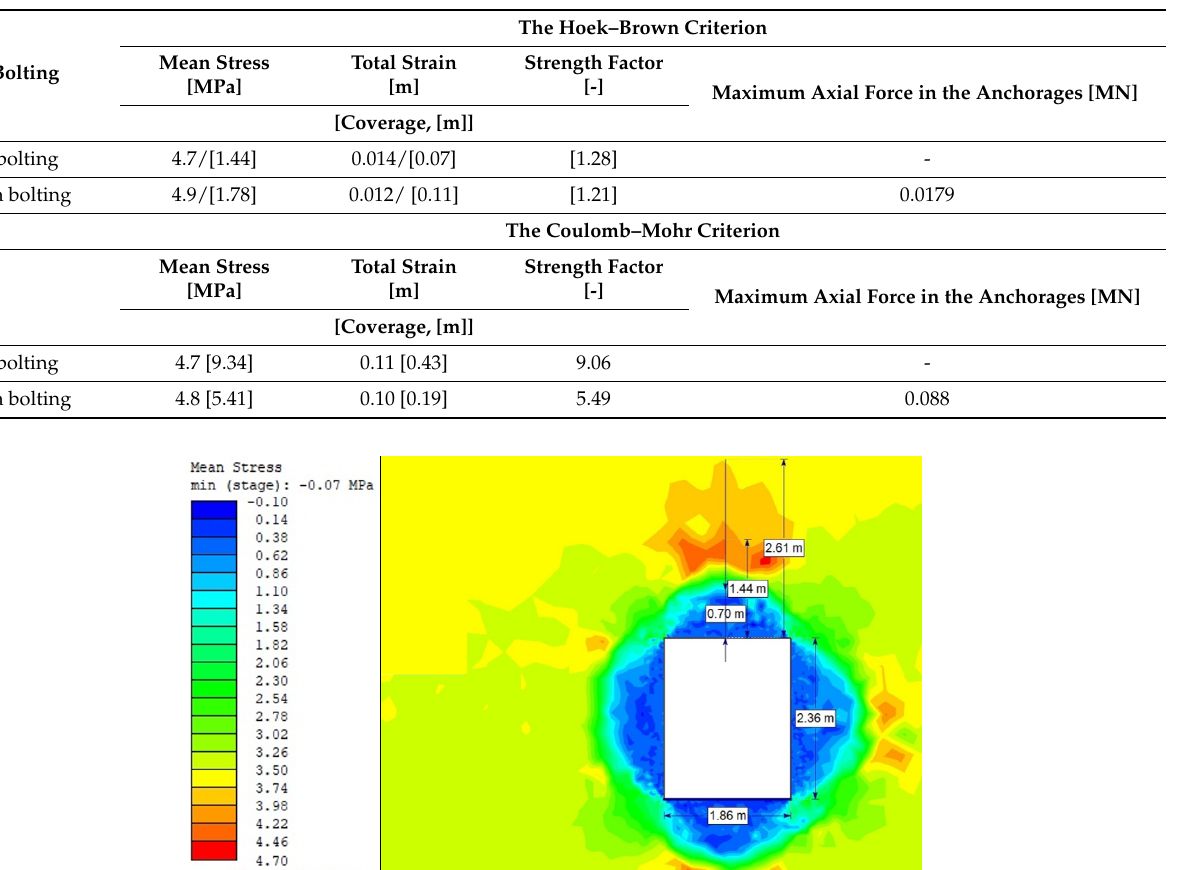
Table 3. Summary of numerical modeling results for the Vernier excavation.